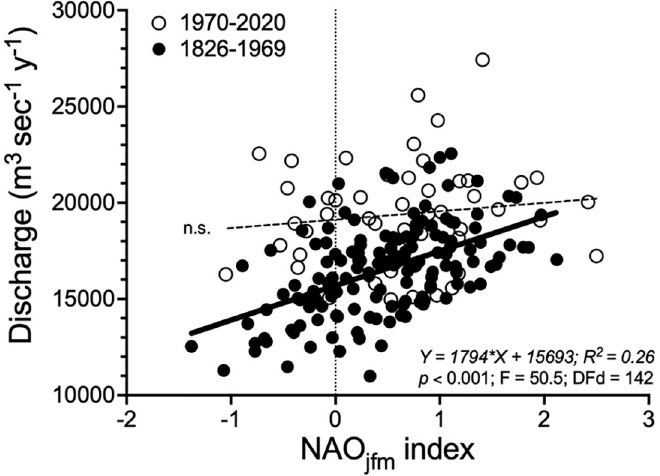
Fig 7. The simple linear regression relationship between the three year running averages for the annual discharge of the Mississippi River at Vicksburg, MS, versus the North Atlantic Oscillation (NAO) Index for January, February and March. The data are separated for between 1826 to 1969 (filled circles) and 1970 to 2020 (open circles). The dark broad line is significant; the dotted line is not significant (n.s.).